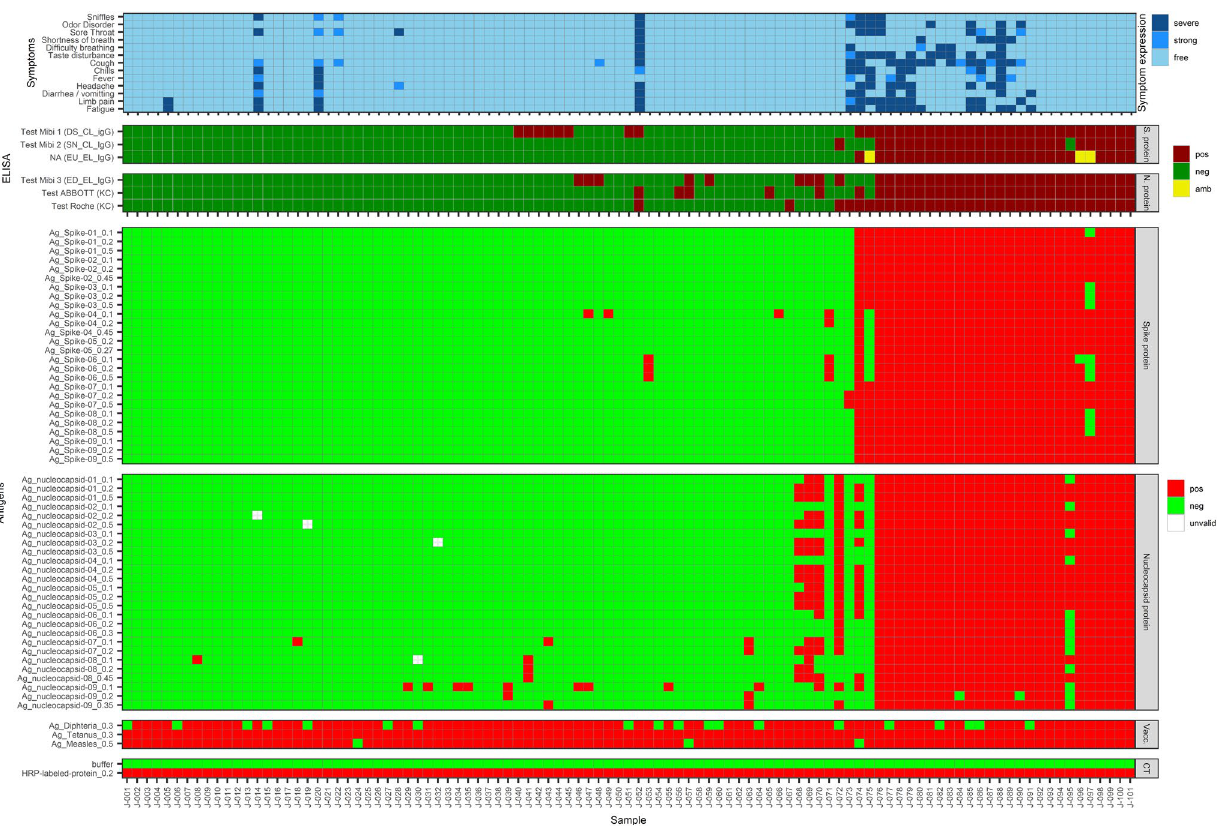
Figure 1. Verification of the new SARS-CoV2-VAC-antigen microarray: 101 ELISA-tested sera from the CoNAN study were tested with a total of 14 antigens spotted at different concentrations and in different buffer